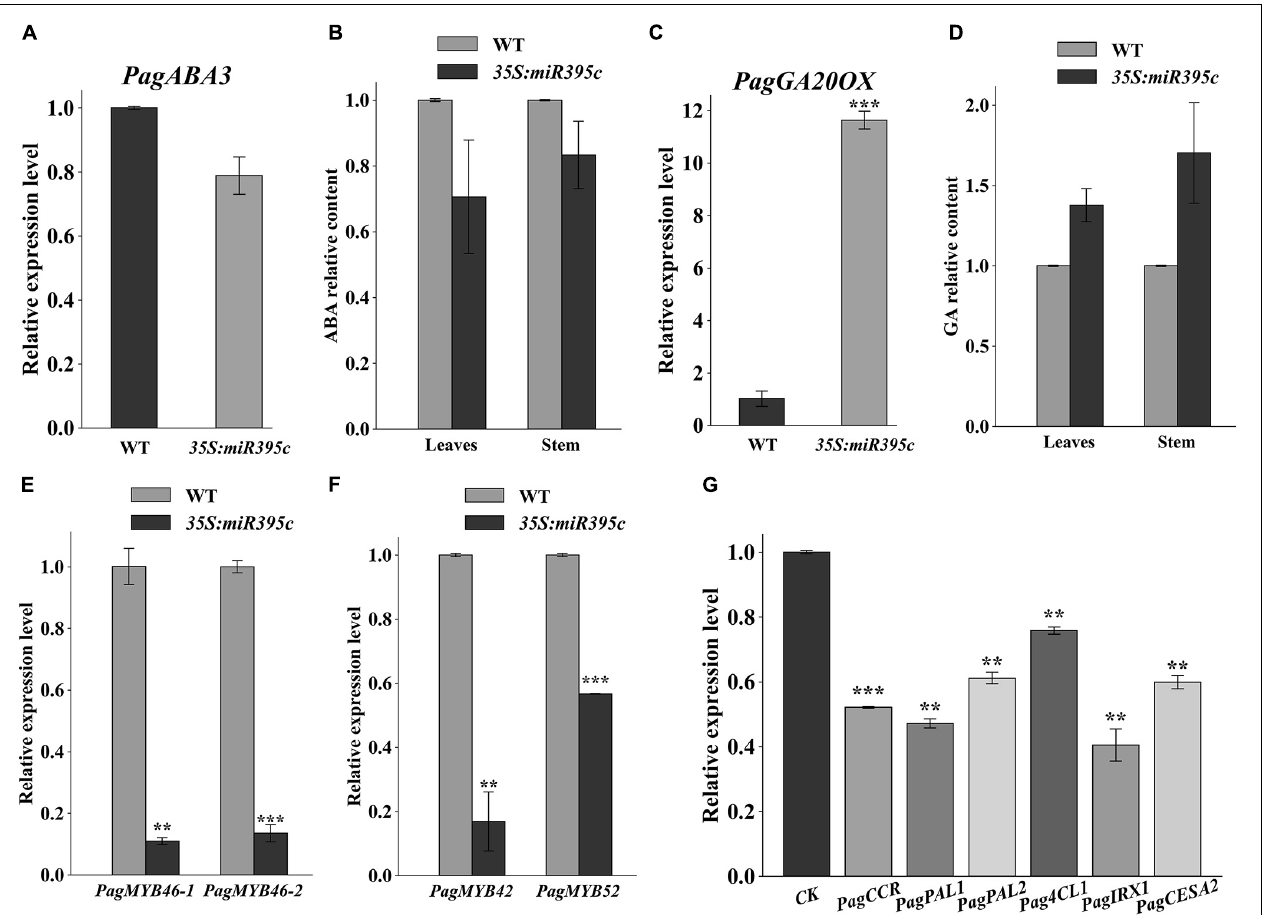
FIGURE 5 | The content of abscisic acid (ABA) and gibberellic acid (GA) in wild type and miR395c-OE poplars, and the expression of genes involved in secondary wall deposition. (A) Relative expression of PagABA3 related to ABA biosynthesis in miR395c-OE poplar. (B) The content of ABA decreased in miR395c-OE poplar. (C) Relative expression of PagGA20OX related to GA biosynthesis in miR395c-OE poplar. (D) The content of GA increased in miR395c-OE poplar. (E) The expression level of PagMYB46 in miR395c-OE poplar. (F) The expression levels of PagMYB42 and PagMYB52 in miR395c-OE poplar. (G) Relative expression of genes involved in secondary wall biosynthesis in miR395c-OE poplar. CK, control check. Asterisks indicate significant difference between transgenic and WT plants using the Student’s t -test, ** p < 0.01; *** p <